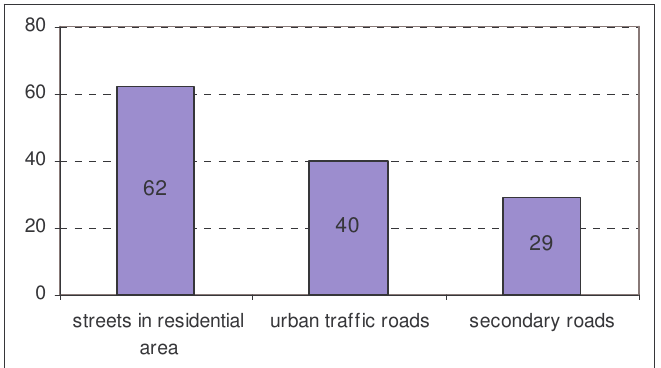
Figure 5. Problem awareness of speeding, per type of road (N=550, % of drivers)